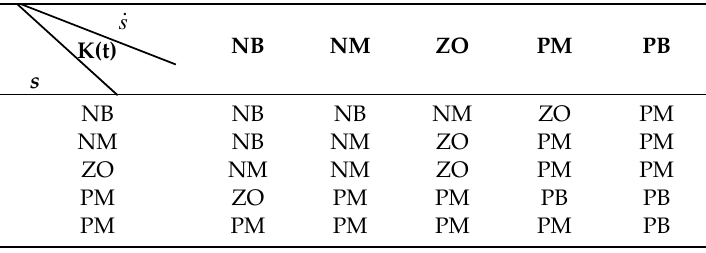
Table 1. Fuzzy set of the system’s input / output. NB: large negative, NM: middle negative, ZO: zero, PM: middle positive, PB: large positive.